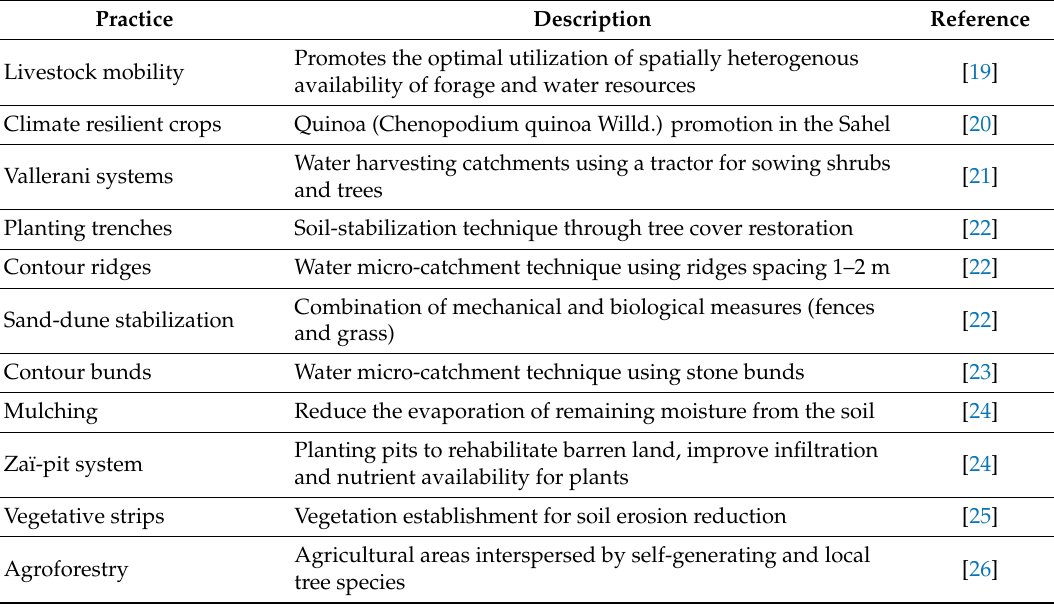
Table 1. Some of the observed agricultural adaptation strategies in Western